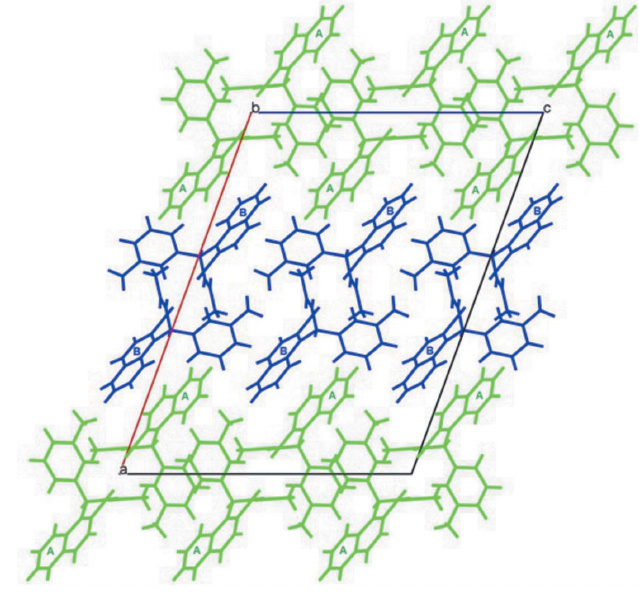
Figure 2 A view along the b axis of the crystal packing of the title compound.